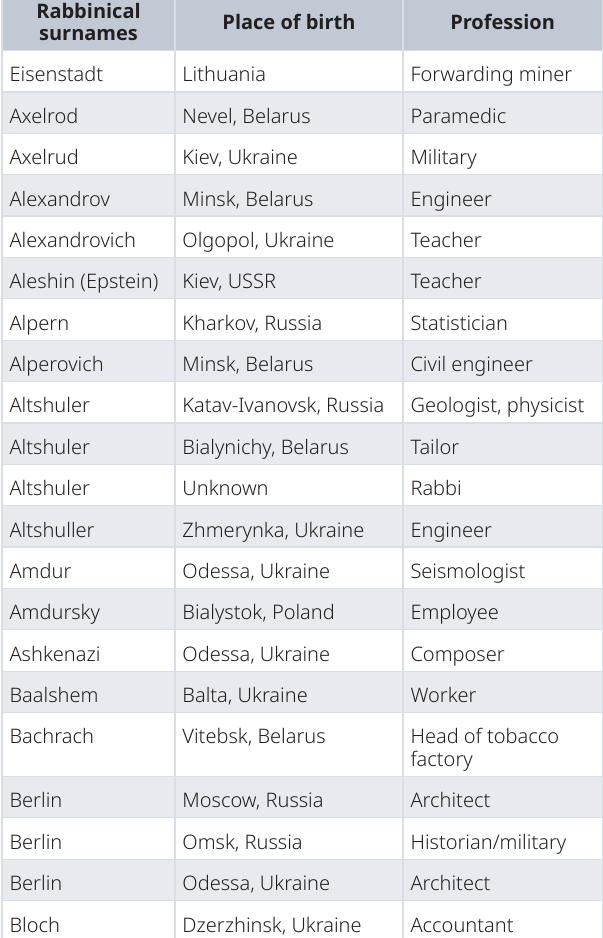
Table 3. Excerpt from the list of surnames with rabbinical origin. Some surnames are different spellings of the same name. These spellings were created in the course of family migrations during centuries because spellings of the same name in official documents differed in different countries, for example due to spelling mistakes in the